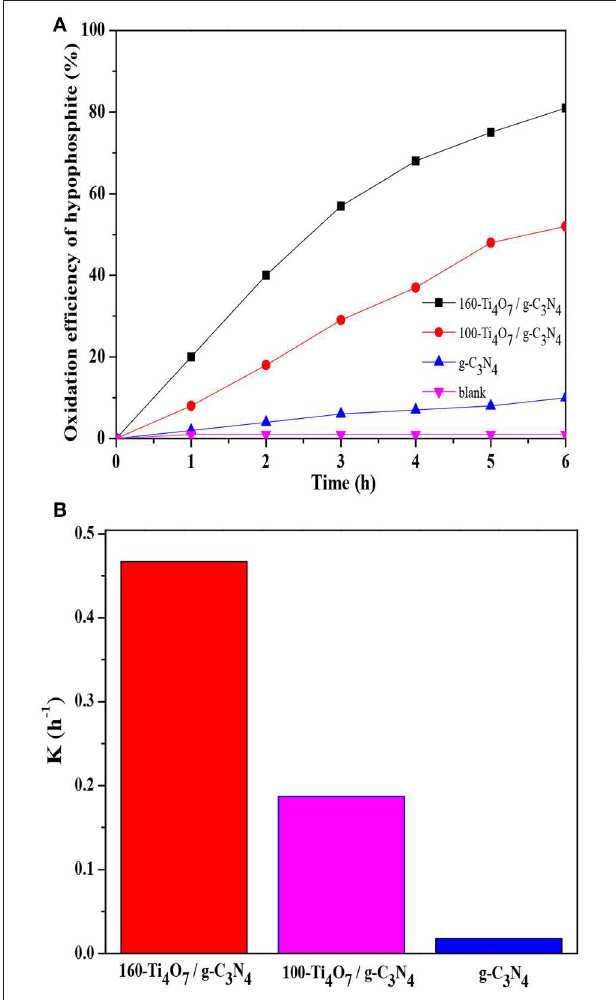
FIGURE 3 | Photocatalytic activity of different photocatalysts. (A) The oxidation efficiency of hypophosphite; (B) The comparison of oxidation rate constant k. FIGURE 4 | Optical properties of different photocatalysts. (A) UV–vis DRS spectra of the photocatalysts; (B) PL spectra of the